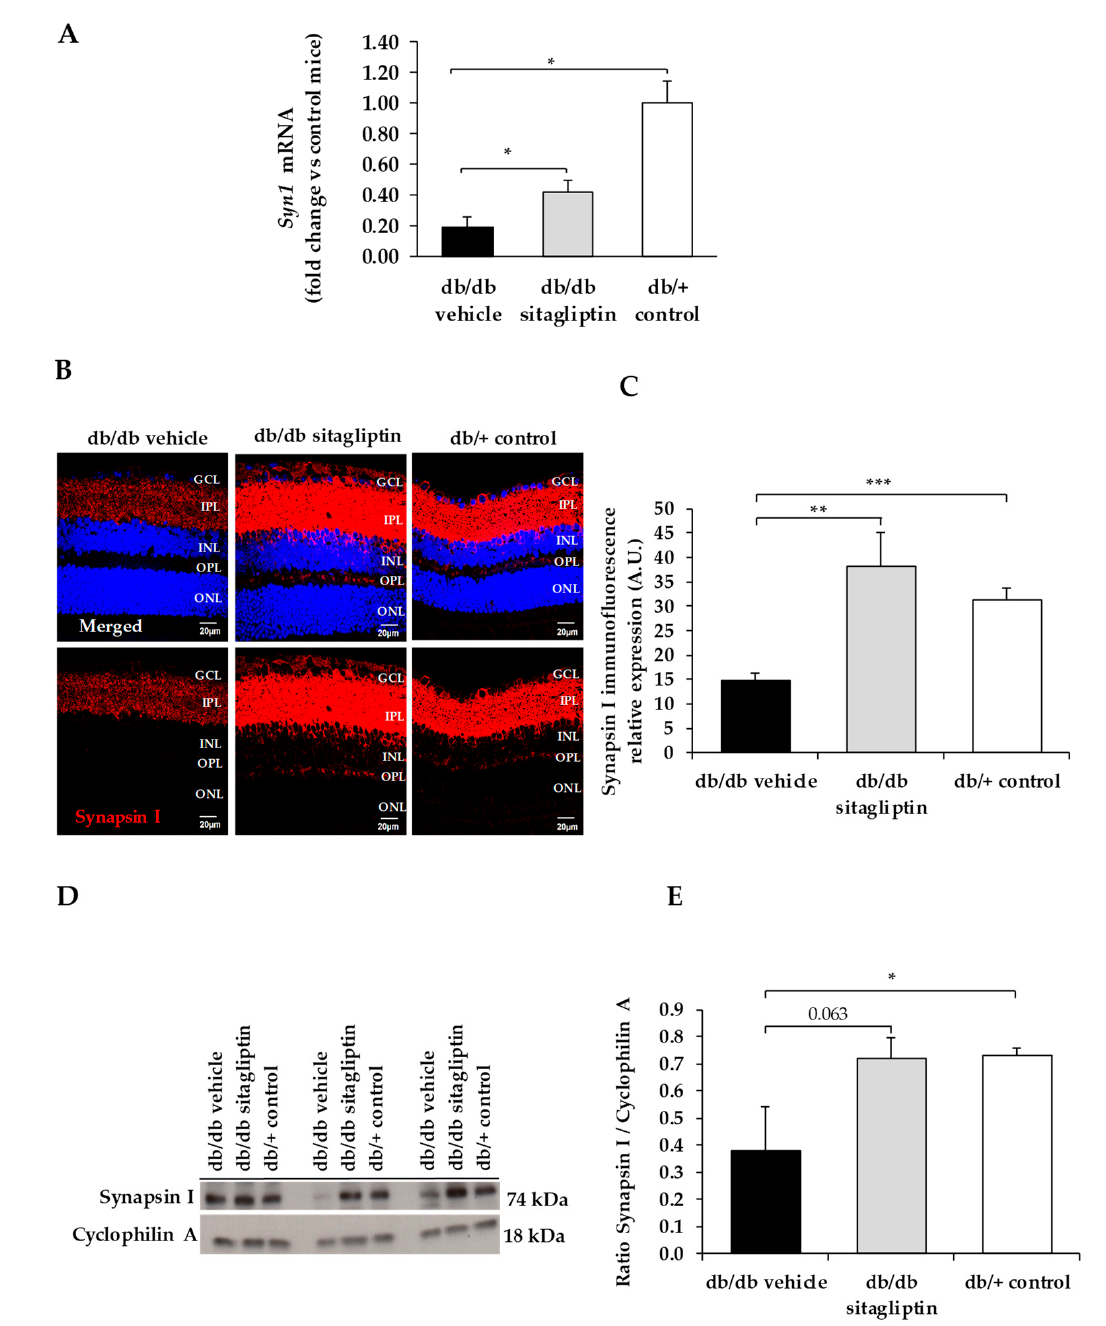
Figure 1. ( A ) Real-time quantitative RT-PCR analysis of synapsin I gene (Syn1) in db/db mice treated with vehicle (black bars), sitagliptin eye drops (grey bars), and in non-diabetic mice (white bars). ( B ) Immunofluorescence of synapsin I (red) among representative samples of diabetic retinas of experimental groups. Hoechst staining (blue) was used for nuclei labeling. ONL: outer nuclear layer; OPL: outer plexifom layer; INL: inner nuclear layer; IPL: inner plexiform layer; GCL: ganglion cell layer. Scale bars, 20 µ m. ( C ) Quantification of synapsin I immunofluoresence in diabetic mice treated with vehicle eye drops (black bars), sitagliptin eye drops (grey bars), and in non-diabetic retinas (white bars). ( D ) Western blot bands of synapsin I and ( E ) Densitometric analysis in db/db mice treated with vehicle eye drops (black bars), sitagliptin eye drops (grey bars), and in non-diabetic mice retinas (white bars). Protein levels were normalized with cyclophilin A. * p < 0.05, ** p < 0.01, *** p < 0.001.